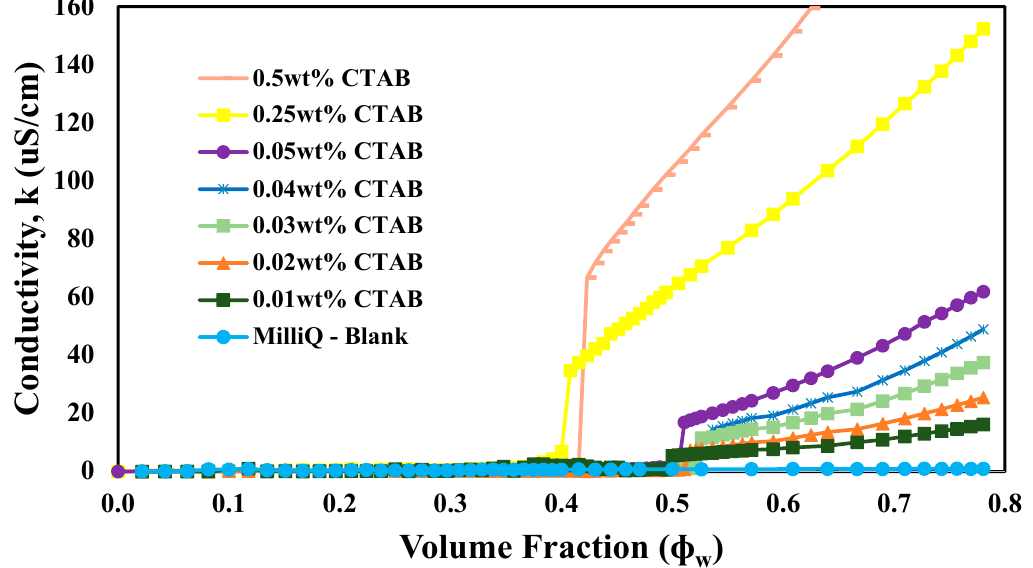
Figure 11. Conductivity of water-mineral oil emulsions stabilized by pure CTAB solutions (0, 0.01, 0.02, 0.03, 0.04, 0.05, 0.25, and 0.5 wt%) as a function of the volume fraction of water.